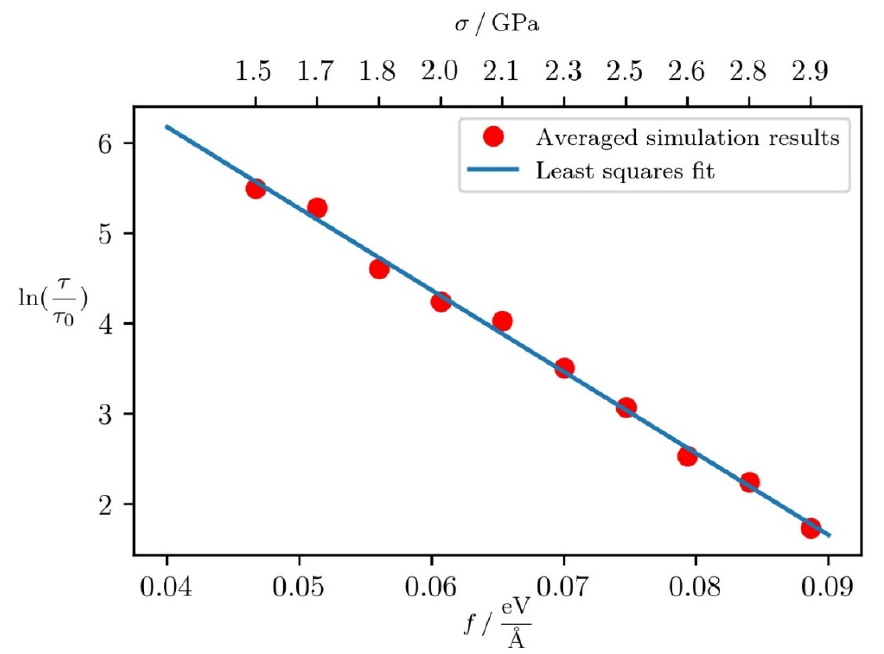
Figure 8. Logarithmic graph of the protrusion formation time under different stress conditions. Each Data point was.averaged over 3 simulations. Least squares fit used to estimate atomic parameters is given by the blue line.